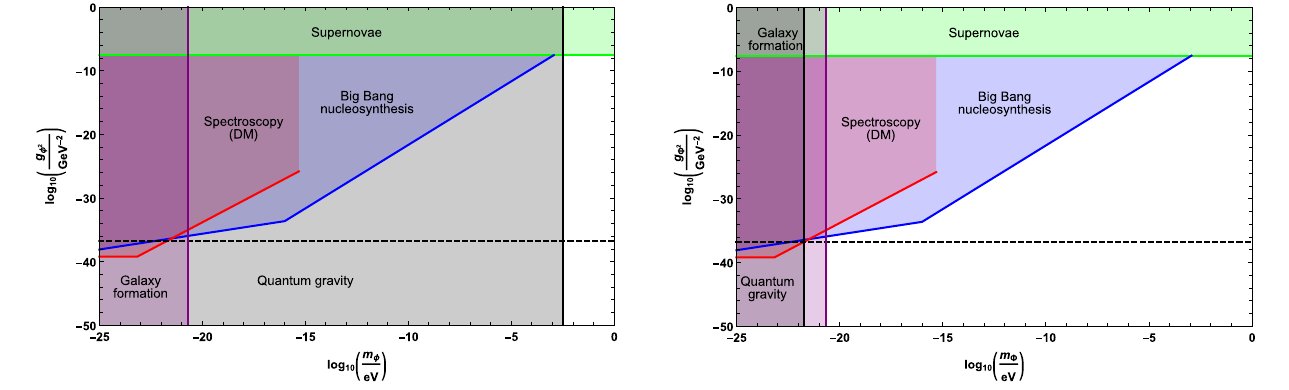
Fig. 4 Limits on the quadratic scalar interaction g φ 2 = c 6 /(cid:4) 6 as a function of the mass of the scalar m φ . Green: limits from supernovae measurements[65].Blue:limitsfromthebigbangnucleosynthesis[20]. Red: limits from atomic spectroscopy [20,24,45]. Purple: limits from galaxy formation, quasar lensing and stellar streams [48–53]. Black: limits from quantum gravity as discussed in this paper. Dashed black line: reduced Planck scale